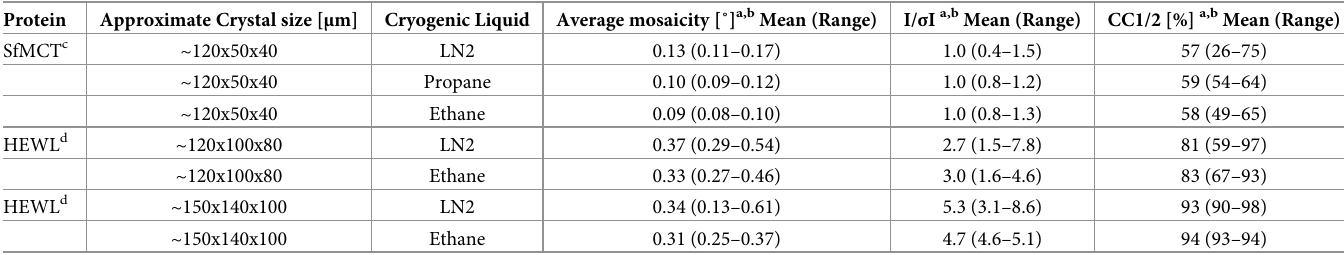
a Each group contained 5 individually harvested and analyzed crystals. The full data is given in S1 Table. b The data reflects values of the highest resolution shell, i.e. for HEWL (1.48–1.40 Å ) and SfMCT (2.96–2.81 Å ). c